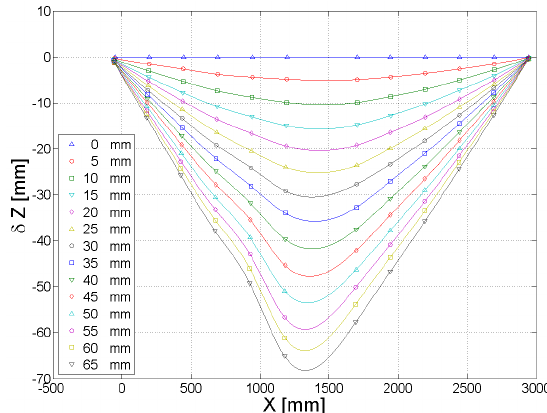
Figure 9. Cubic spline plots of the beam deflections for the first experiment using the photogrammetric reconstruction